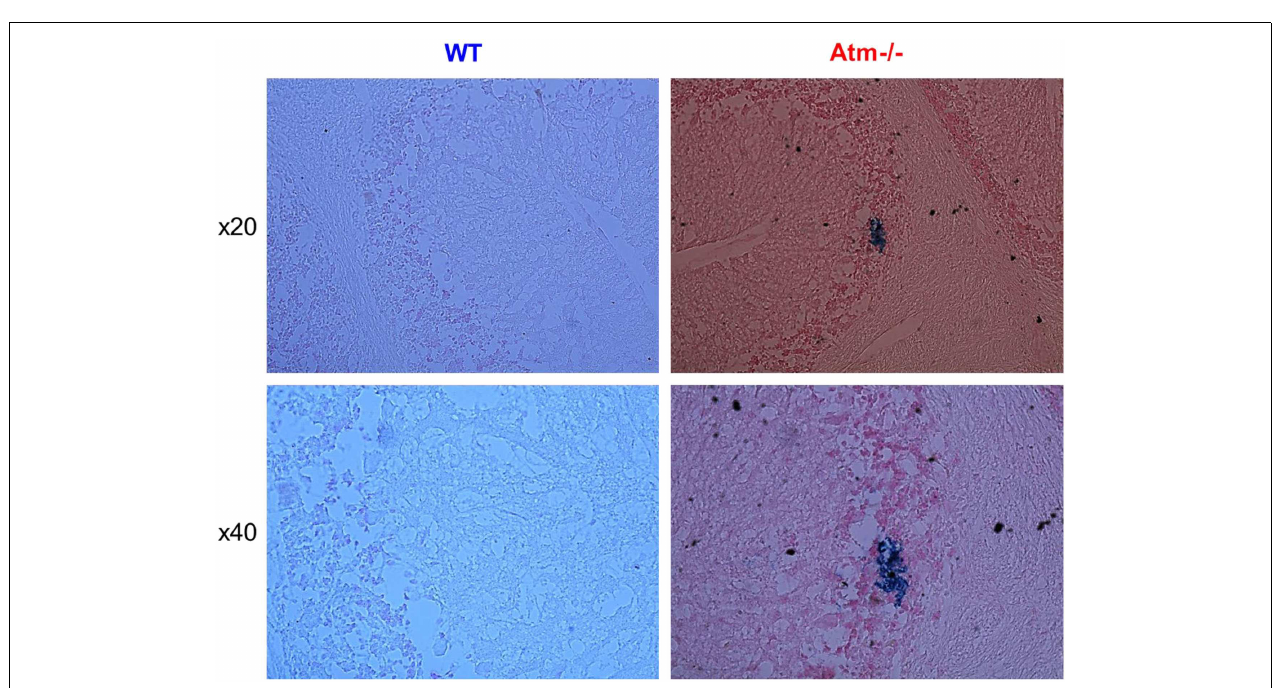
larger magnification ofWT and Atm − / − cerbella. Blue deposits of hemosiderin were evident in cerebella of Atm − / − mice (several indicated with arrows), but scarcely in cerebella ofWT